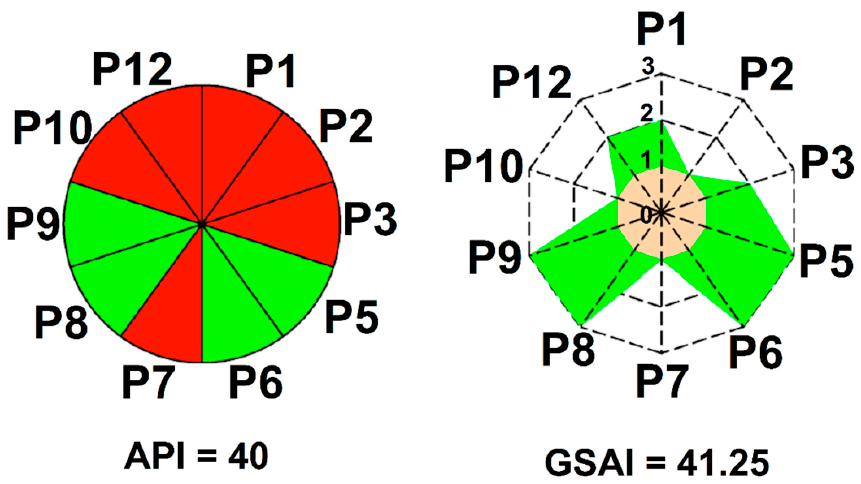
Figure 12. Example of green metric in comparison with green star metric. The green color is for the accomplished principle, the red color, if it is not. Adapted from Refs. [70,84–87].